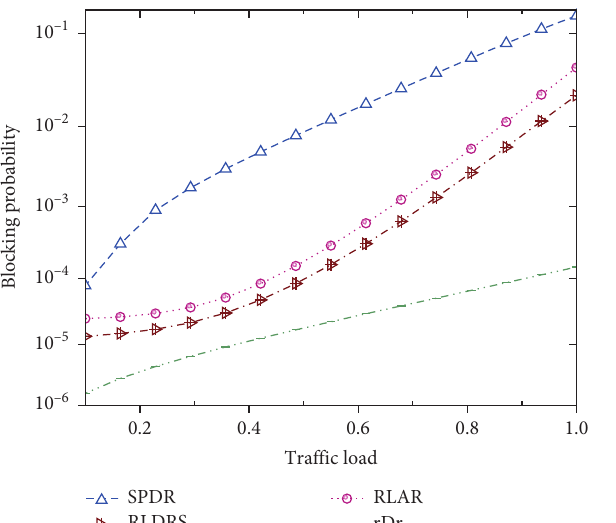
Figure 14: Total number of deflections versus number of nodes.